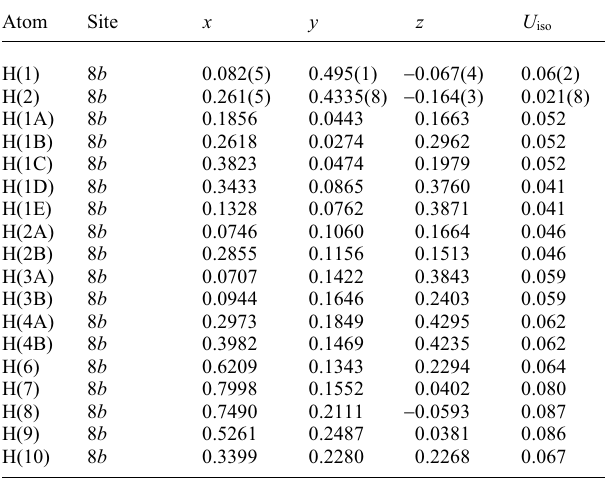
Table 2. Atomic coordinates and displacement parameters (in Å 2 )